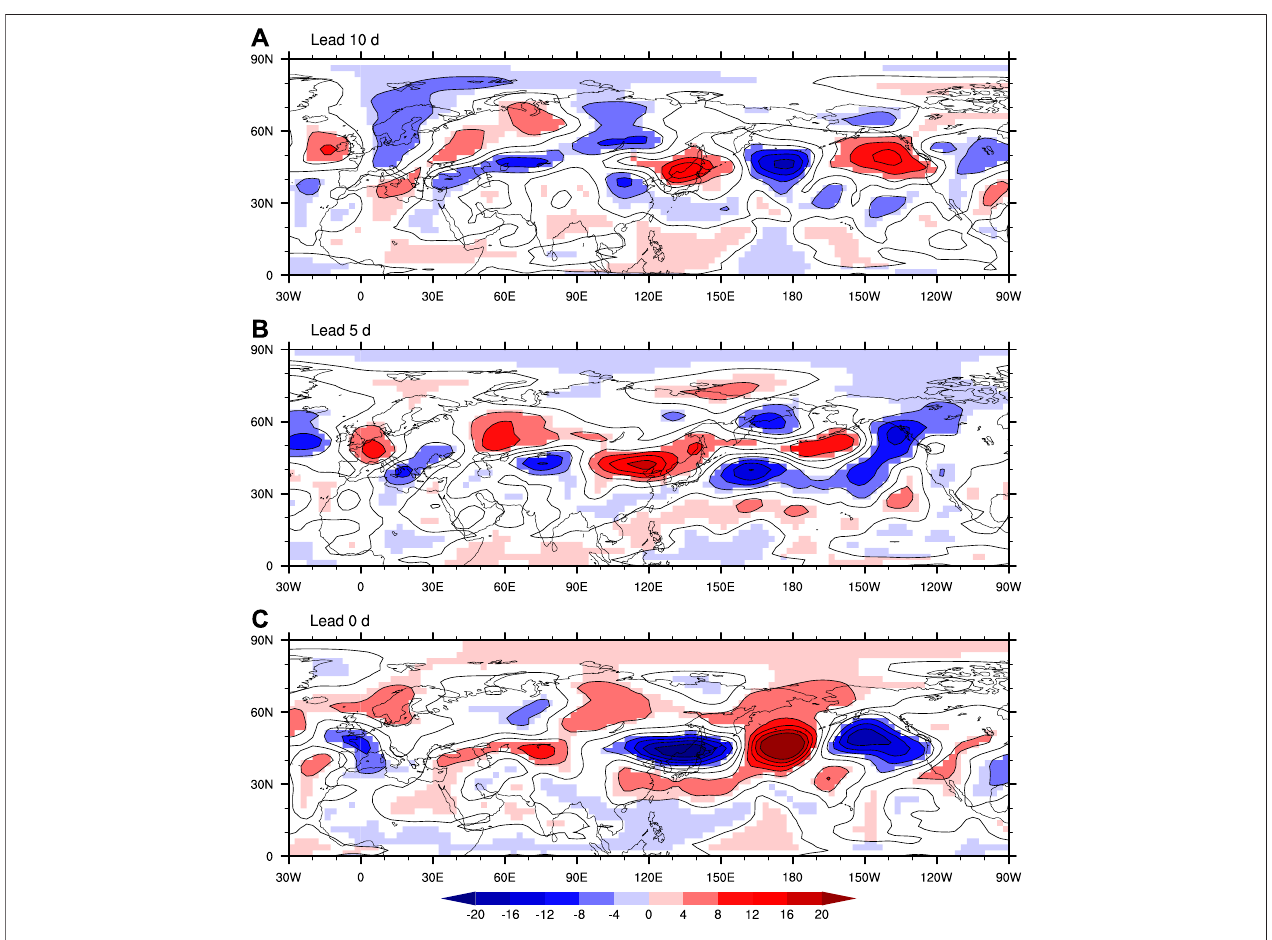
FIGURE 6 | As in Figure 3 , but for potential vortex (PV, shaded, unit: 10 – 8 K s − 1 kg − 1 ) at 200 hPa.